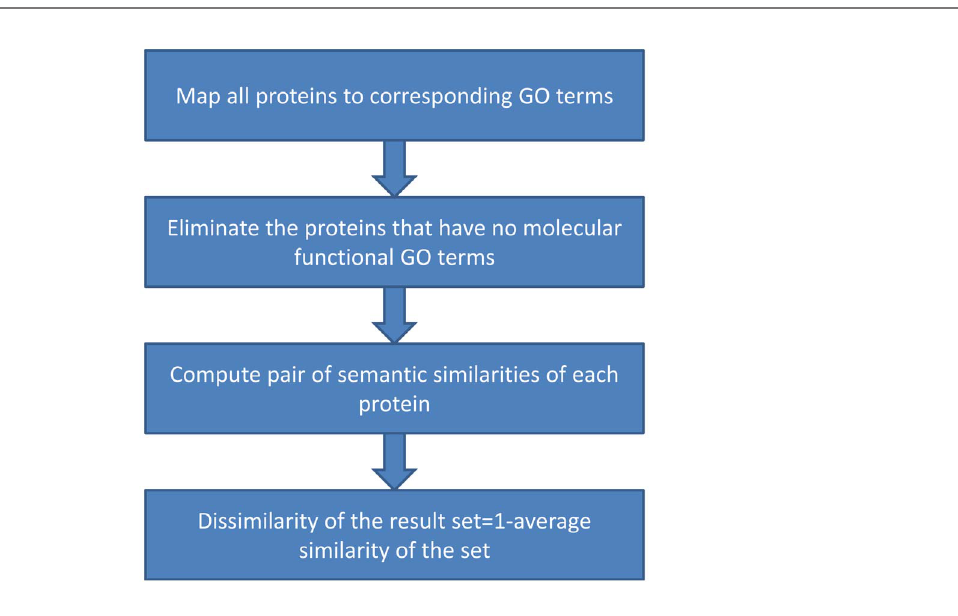
Fig. 3. The steps for finding the functional diversity of a set of protein